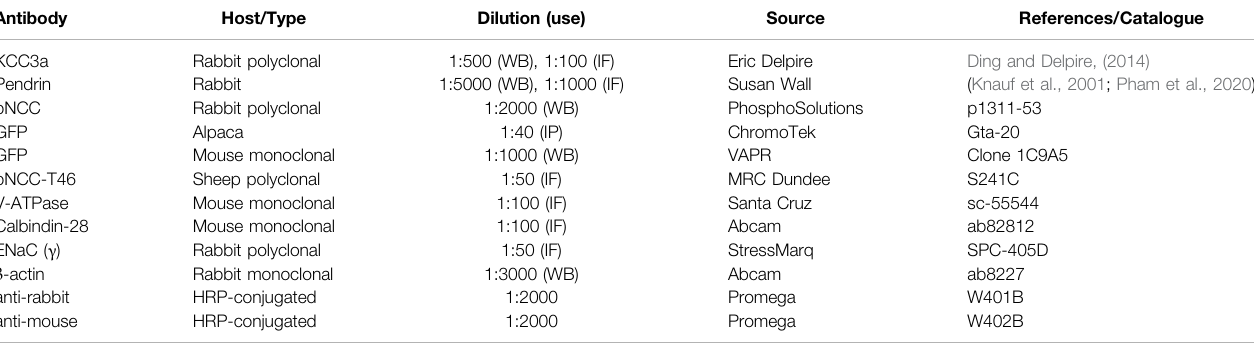
TABLE 1 | Antibodies.